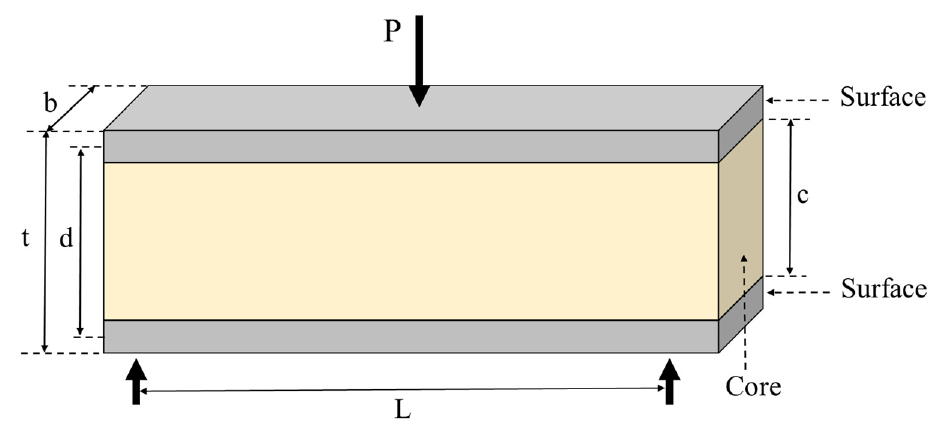
Figure 13. Dimensions of the SIP samples.